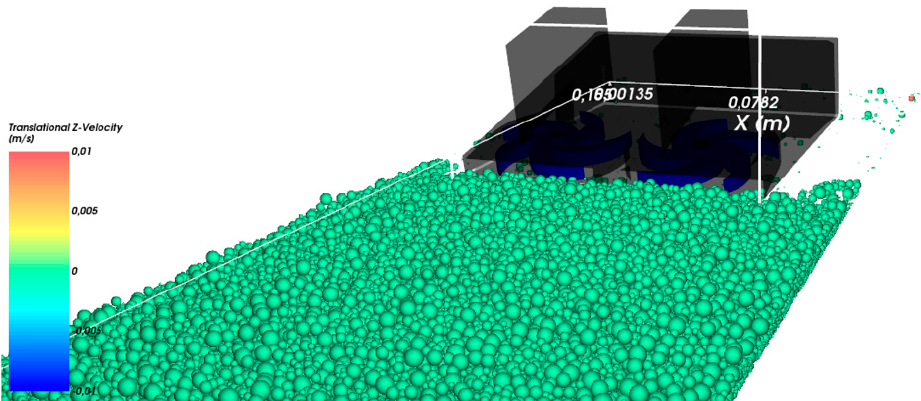
Figure 4. Starting conditions—isometric view with box transparency option. In the presented simulations, spherical particles were used with the sieve size varying from 0.5 to 4 mm. The DEM solver used the model based on the hysteric linear spring formula for the calculation of normal forces and the linear spring coulomb limit model for the tangential forces. To determine the rolling resistance, the linear spring rolling limit model was used. The static and dynamic friction coefficient between particles was defined as 0.7 and between machine parts and particles as 0.3. The values used in the calculations are the ones that are most often used by scientists in similar simulations [20,21]. Total tangential stiffness in contact was also assumed. Such assumptions are best suited to ideal spherical shapes used in the experiment. Due to limited computational capabilities, the duration of the simulation was limited to 8 s. During this time, the harvester moved at a speed of 0.01 m/s, and its blades rotated at a speed of 2 rad/s, collecting spherical particles. Despite such a short simulation time, computing on one GPU card took over 24 h for each calculation. In Section 5, the results obtained for three different values of gravitational acceleration, corresponding to those on the Earth, Moon, and Mars, are presented. Collecting process is shown in Figure